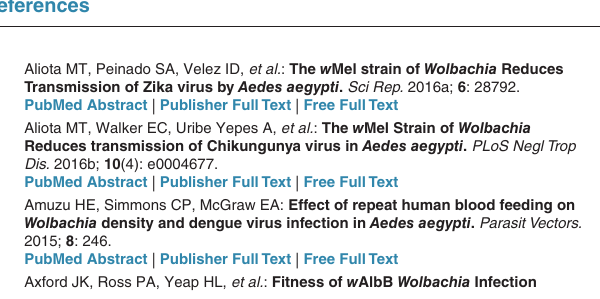
Figshare: CNS_Monitoring_Results.xlsx. https://doi.org/10.6084/ m9.figshare.9831113 (Ryan,